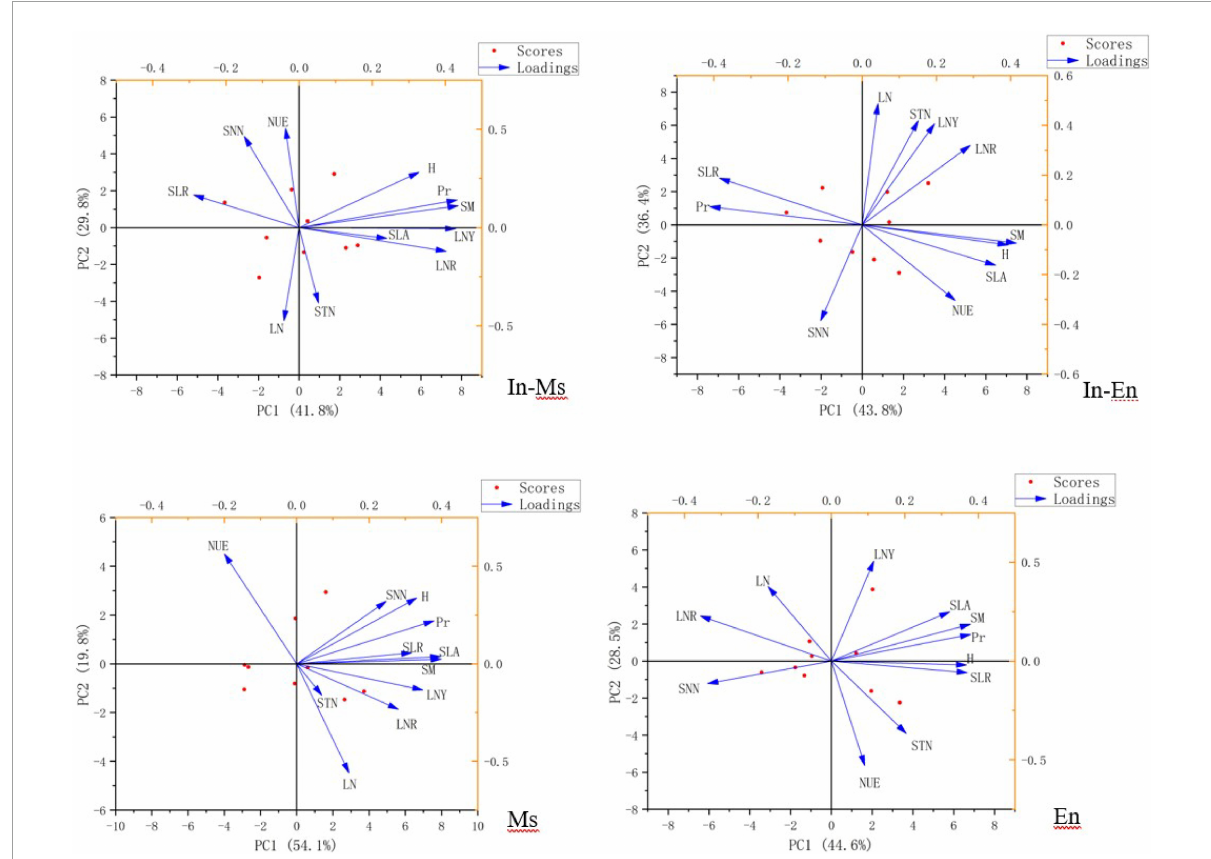
FIGURE10 Factor analysis of nitrogen content, utilization, and traits of forages (SM, soil moisture; SNN, soil nitrate-nitrogen; NUE, nitrogen use efficiency; SLA, specific leaf area; H, height; Pr, productivity; SLR, ratio of stem to leaf; LNY, nitrogen yield of leaf; LNR, nitrogen distribution in roots, stems, and leaf; STN, soil total nitrogen content; LN, nitrogen content of